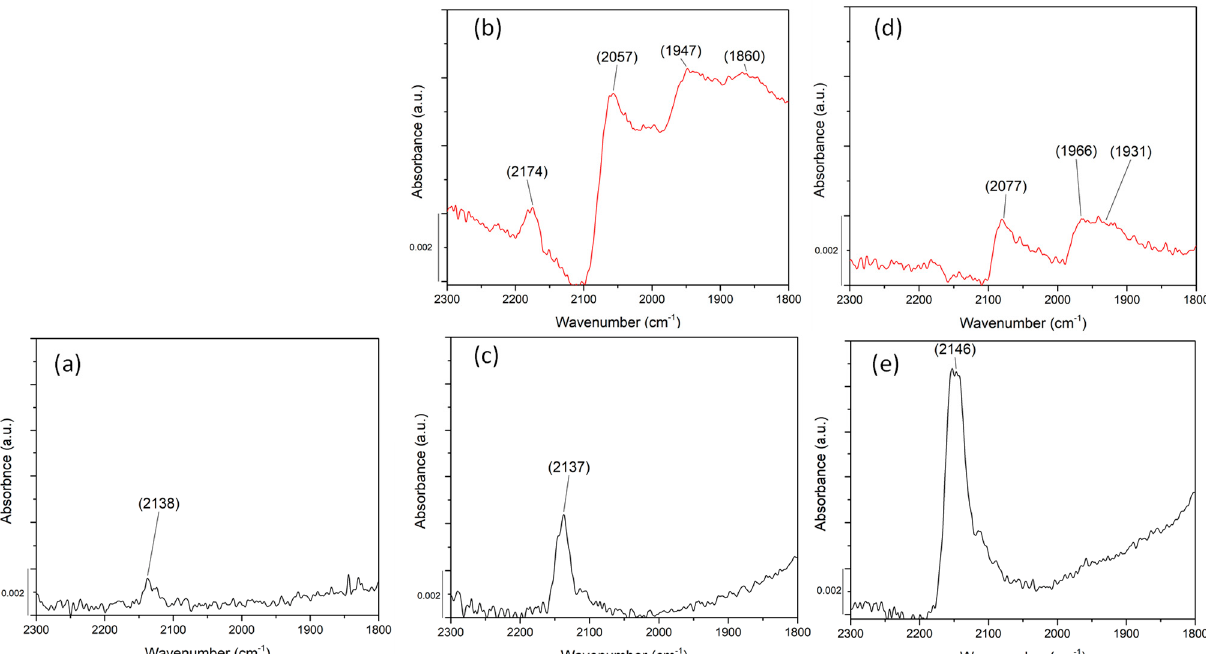
Figure 5. FTIR spectra of Pd-HS after different pre-treatments: ( a ) after two successive oxidation steps in O 2 at 600 °C for 30 min each, ( b ) after a reduction in H 2 at 500 °C for 1 h, ( c ) after a re-oxidation step at 600 °C for 1 h, ( d ) after two successive reduction steps in CO at 500 °C for 30 min each and ( e ) after a re-oxidation step at 500 °C in O 2 . The spectrum of gaseous CO was subtracted. ( a , b , c , d : 1 Torr CO. e : 1.46 Torr CO).